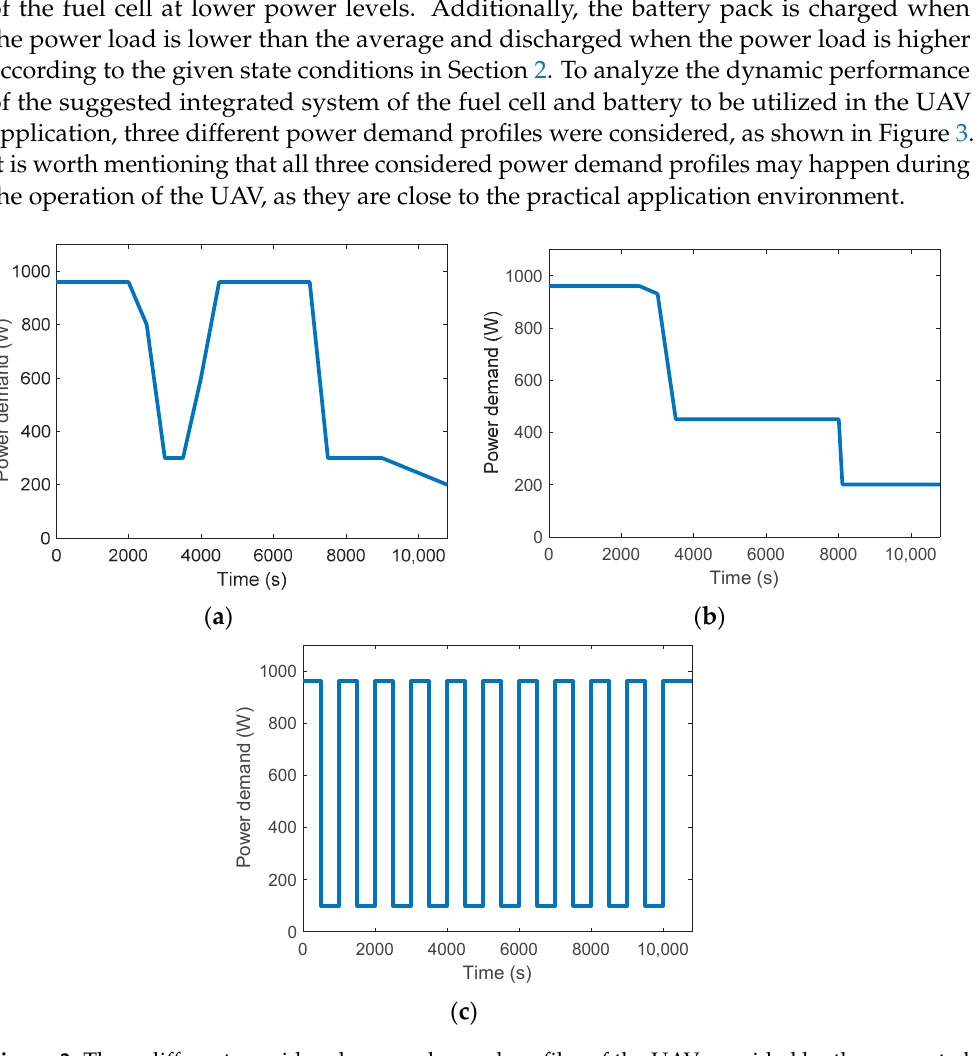
Figure 3. Three different considered power demand profiles of the UAV provided by the suggested integrated system of the fuel cell and battery: ( a ) case 1, ( b ) case 2, and ( c ) case 3.